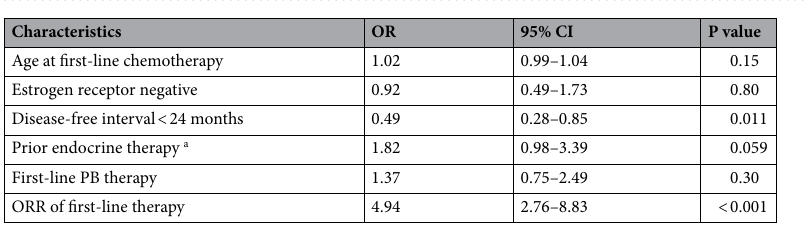
Table 2. The relative risk of longer time to treatment failure of first-line chemotherapy according to patient and tumor characteristics (logistic regression). CI confidence interval, OR Odds ratio, ORR overall response rate, PB paclitaxel plus bevacizumab. a Endocrine therapy for advanced breast cancer treatment before first-line chemotherapy.